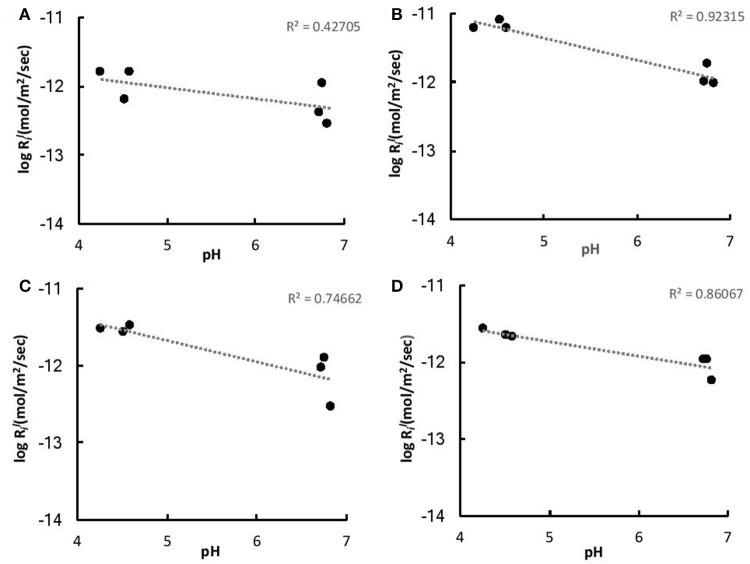
LogRil values of K (A), Ca (B), Mg (C), and Fe (D) vs. the average pH of the initial growth phase (days 1–7).